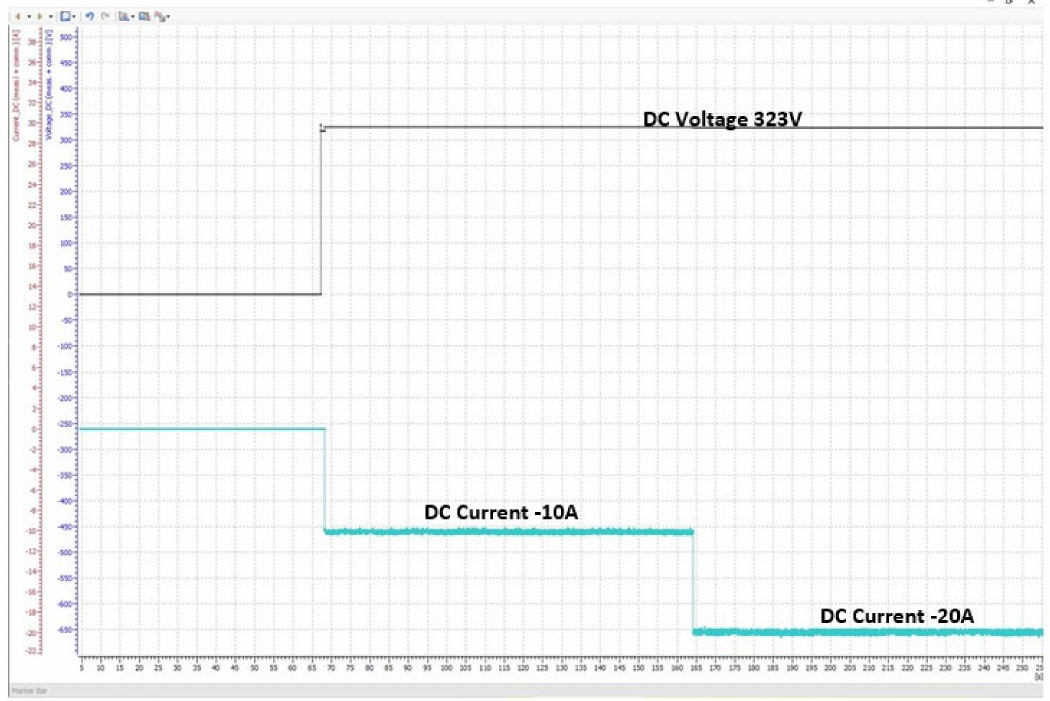
Figure 10. Measurement of DC voltage and current via CAN